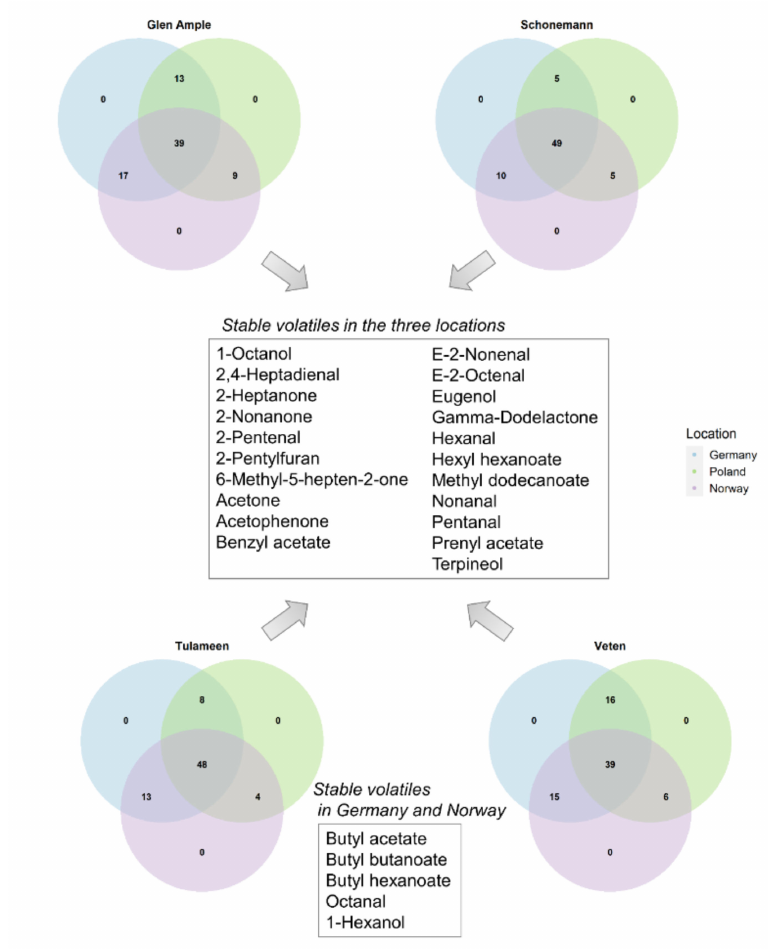
Figure 7. Venn diagrams showing stable volatiles ( p < 0.05, ANOVA) among the different locations in the four assessed cultivars. Volatiles with stable content in the three locations (central box) and in both the Germany and Norway growing sites (lower box) are listed. Only the volatiles for which content did not differ significantly among locations in the four cultivars independently are